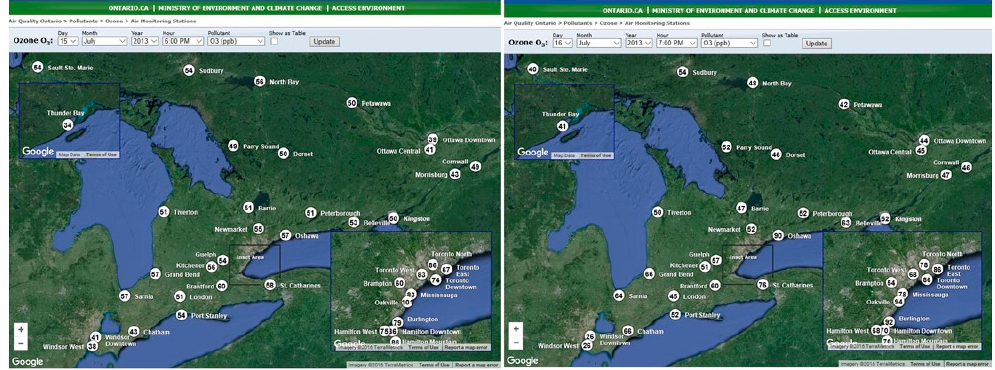
Figure 19. One-hour O 3 concentrations at local time 18:00 15 July (left) and local time 19:00 16 July (right), 2013. Credit: Ontario Ministry of Environment and Climate Change, website: http://www.airqualityontario.com/ (last accessed 9 January 2017).